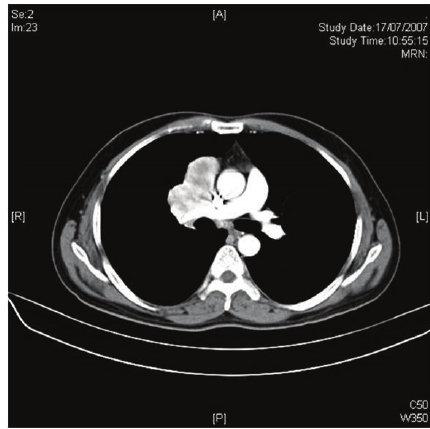
Figure 2: CT thorax showing densely enhancing anterior and middle mediastinal mass.